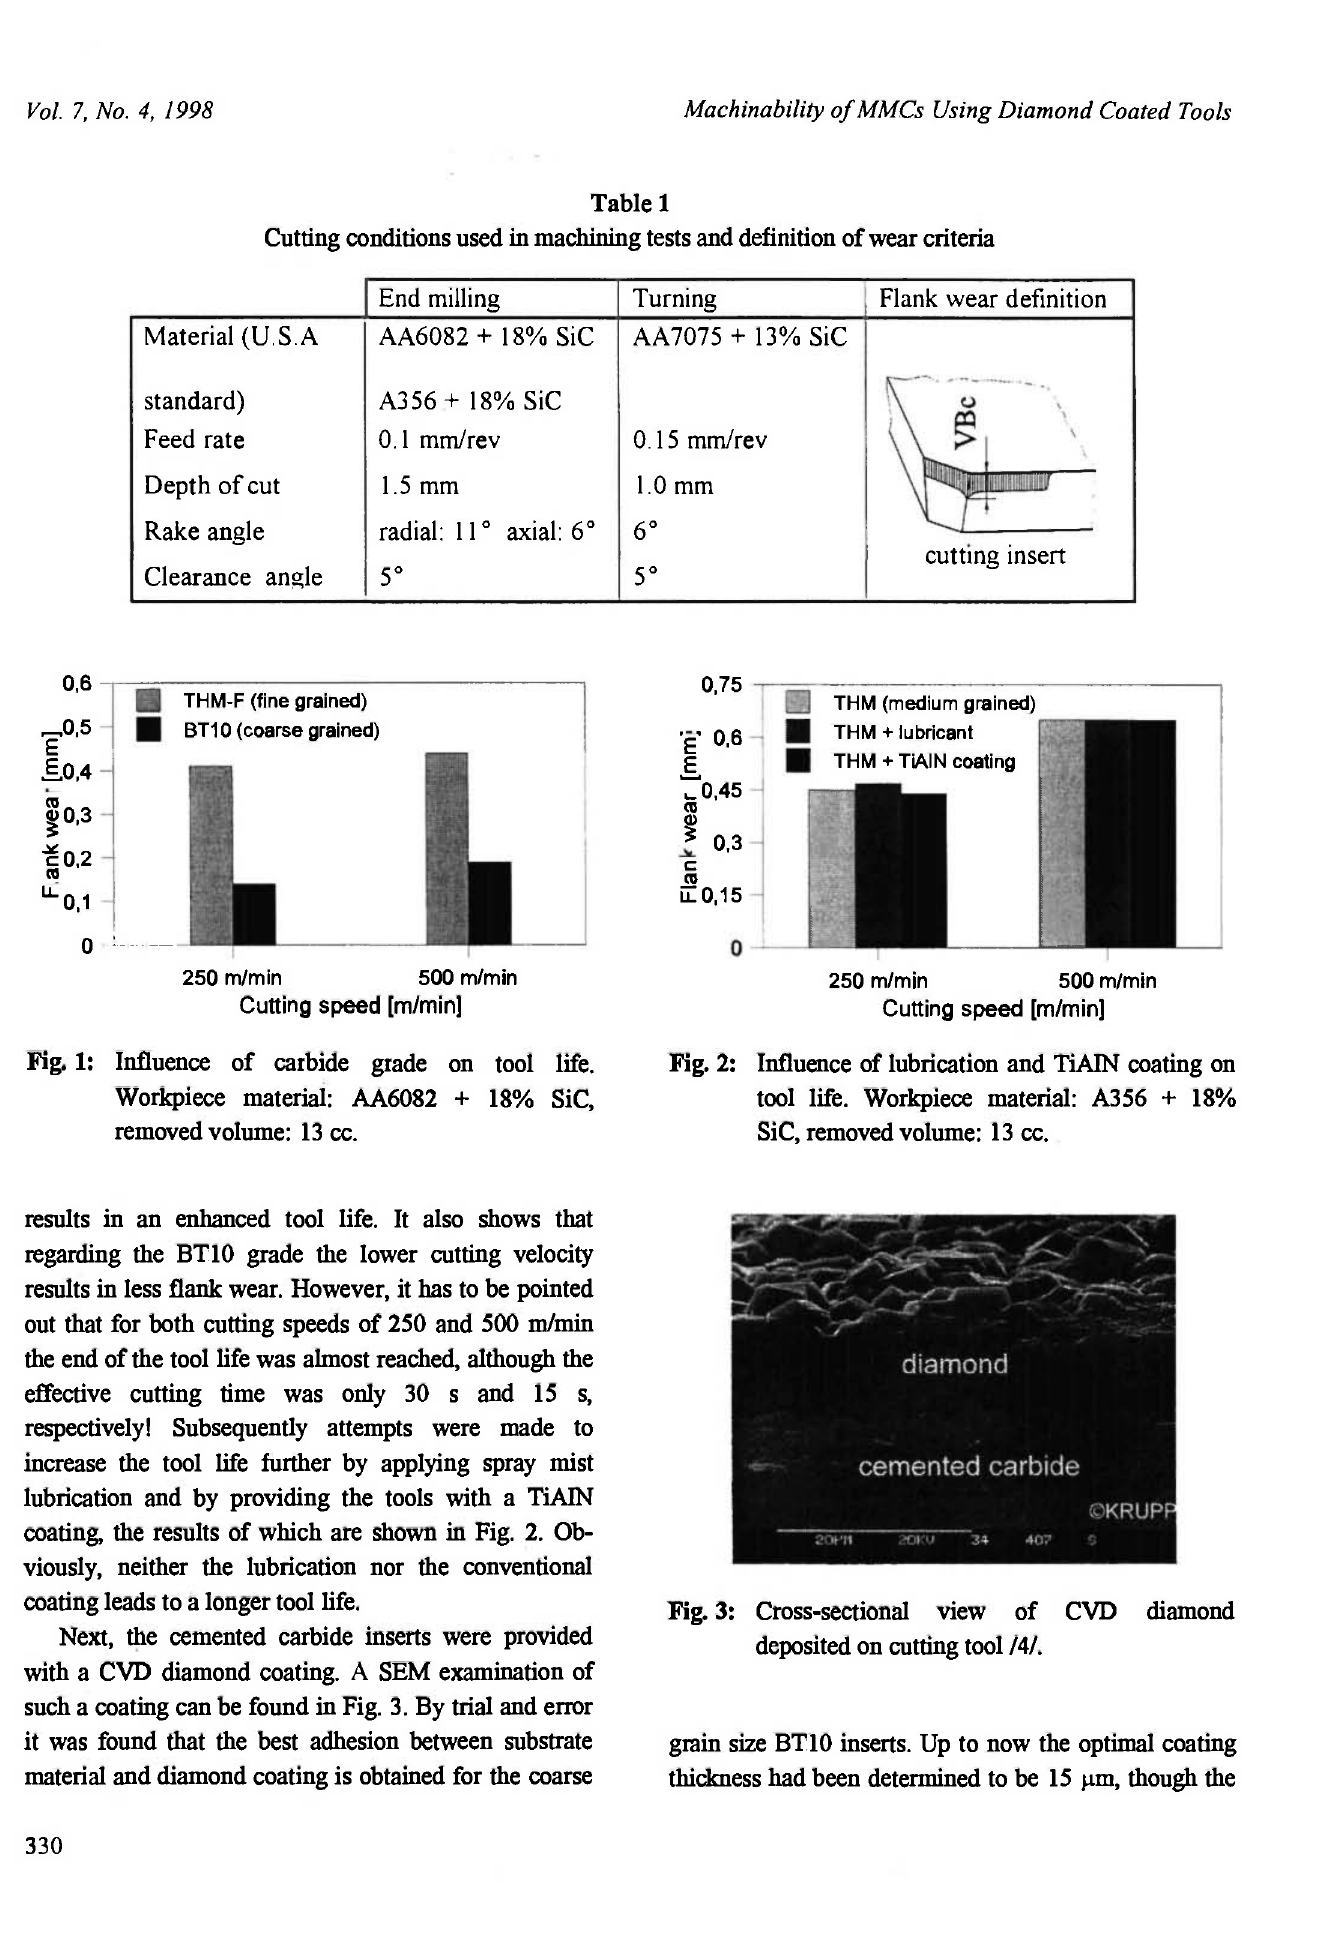
Cutting conditions used in machining tests and definition of wear criteria